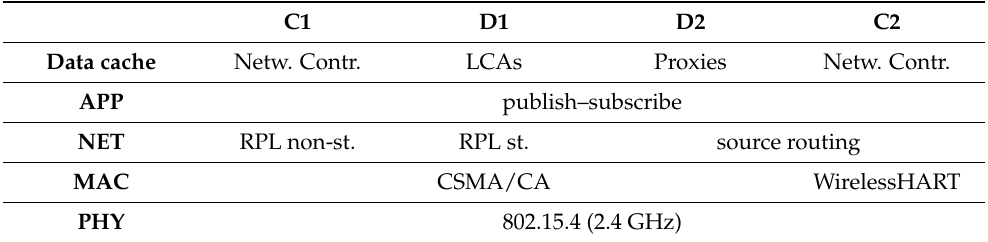
Table 2. Layout of the compared